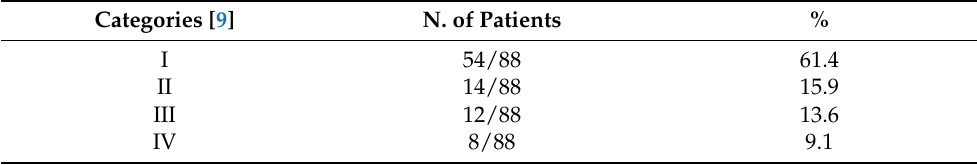
Table 2. Categories of patients according to Quer et al.